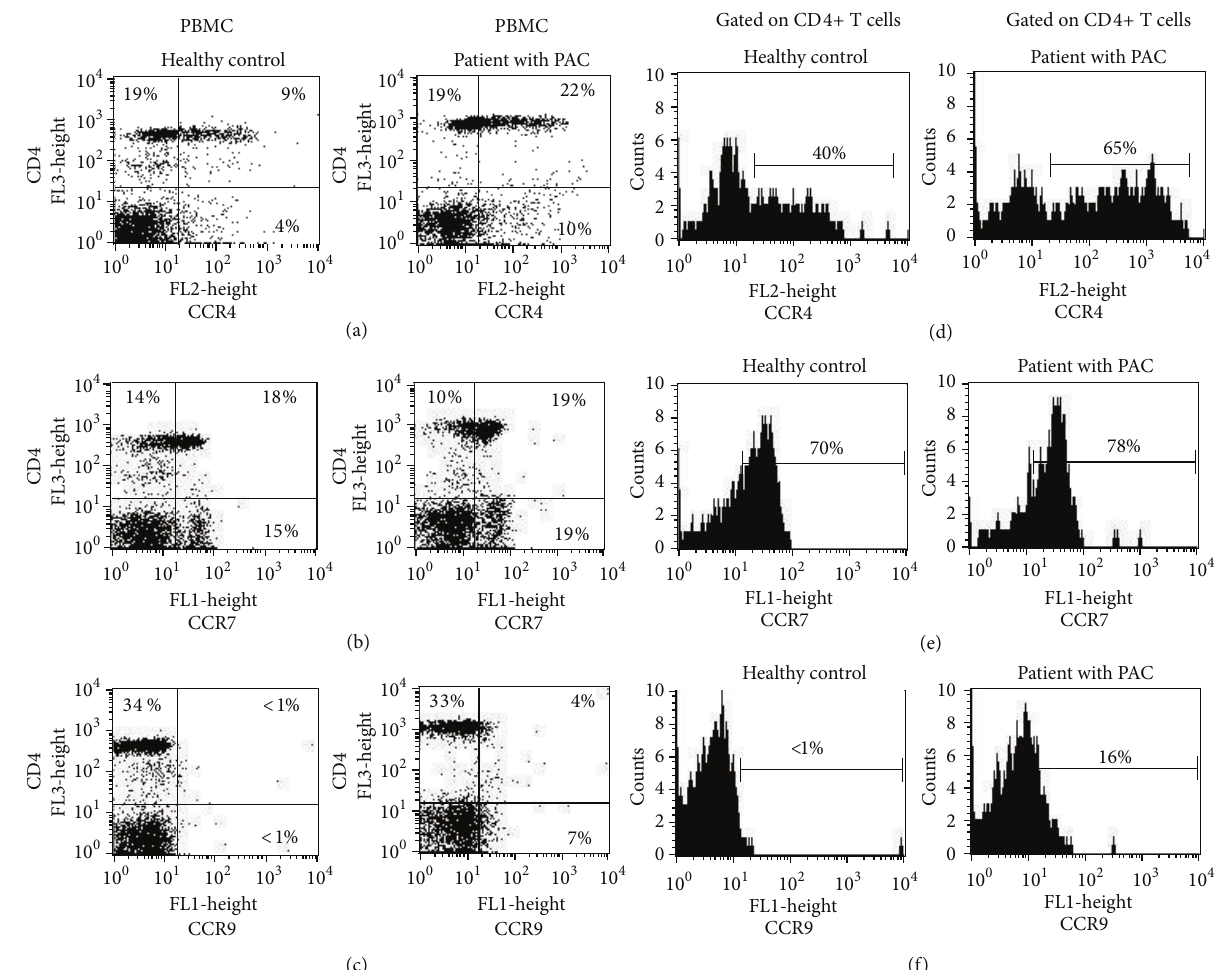
Figure 2: Frequency of chemokine receptors positive cells on circulating PBMC from healthy controls (HC) and from patients with perennial allergic conjunctivitis (PAC) PBMC were stained with fluorescence-conjugated antibodies to CD4 and (a) CCR4, (b) CCR7, and (c) CCR9, in a double-immunofluorescence assay, as described in materials and methods. Representative histograms of CD4+ gated cells are shown (d) CD4+CCR4+, (e) CD4+CCR7+, and (f) CD4+CCR9+ cells in both, HC and patients with PAC. Representative dot plots and histograms from 7 HC and 14